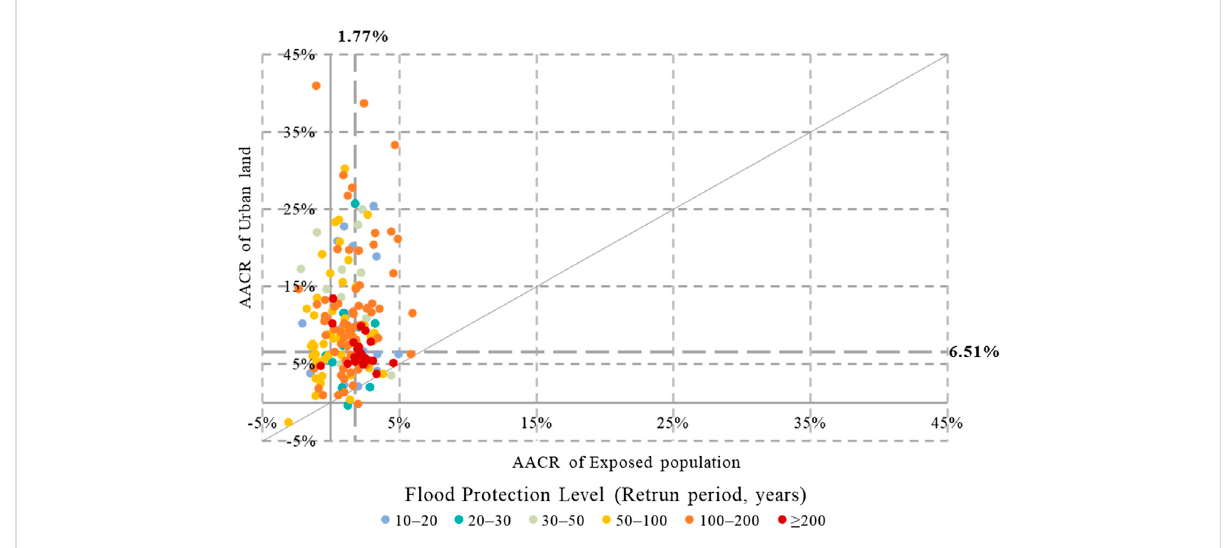
FIGURE 6 The scatter diagram of average annual change rate of urban lands in CFAs and exposed population under different FPLs during 2000 –